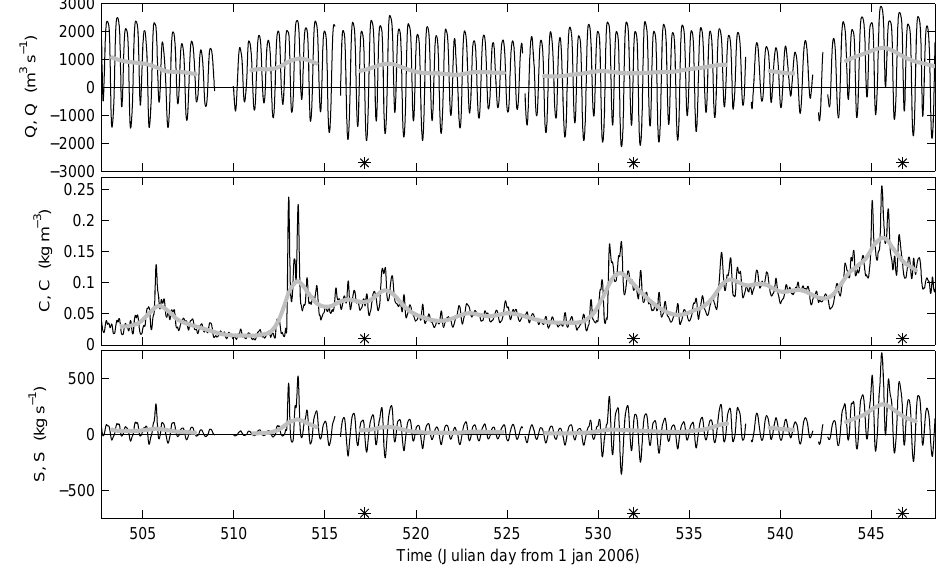
Fig. 8. Discharge (top panel), suspended sediment concentration averaged over the cross-section (middle panel) and suspended sediment load (bottom panel) during the 6.5-week period. The thick grey lines indicate the tidal average, and the stars indicate moments of spring tide.